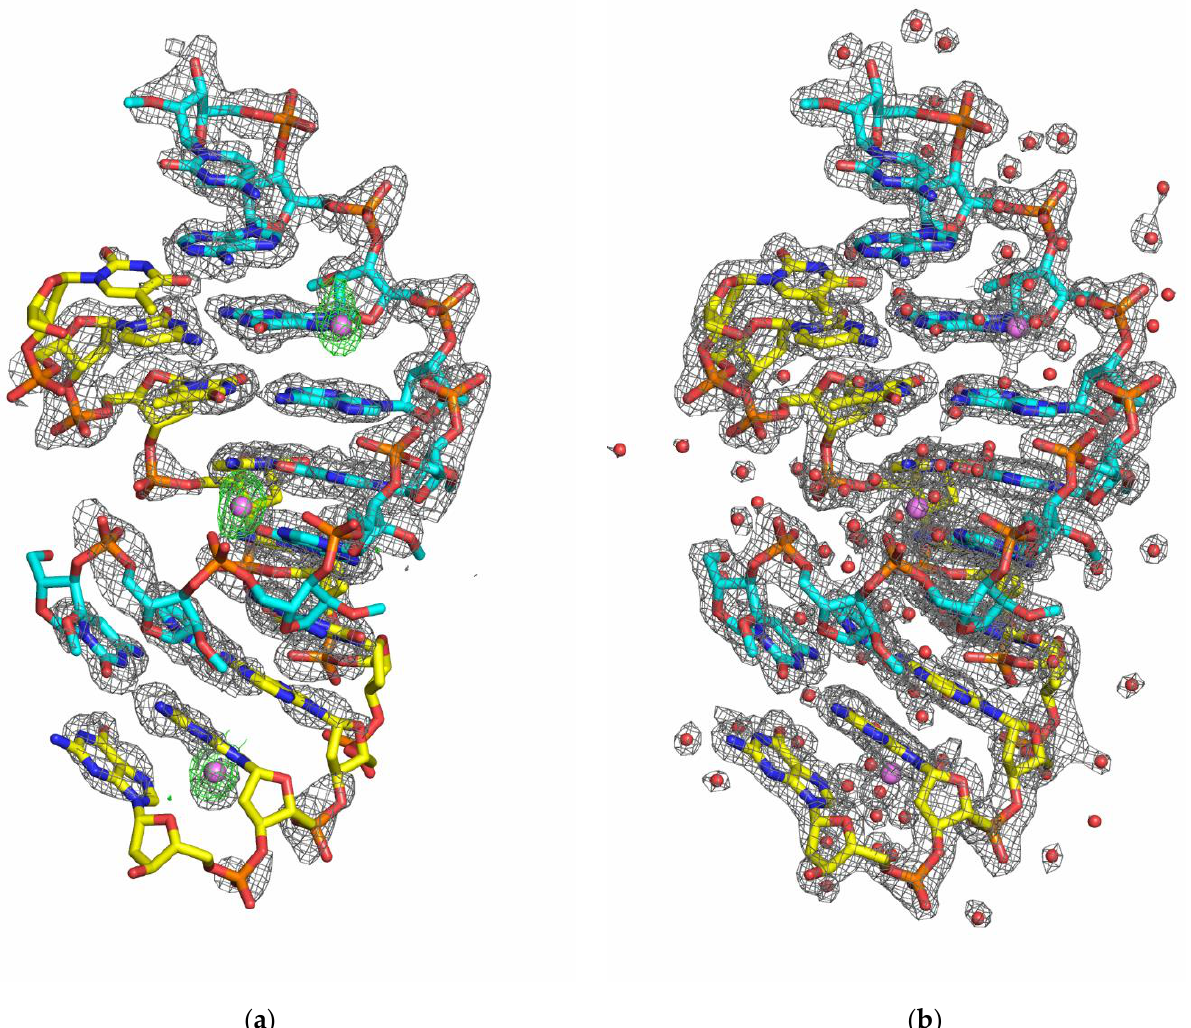
Figure 3. The crystal structure of the overhanging DNA:2 (cid:48) -OMe-RNA duplex. ( a ) The initial density- modified electron density map contoured at the 1.0 σ level (SHELXE output; grey mesh) with an anomalous electron density map contoured at the 3.0 σ level (green mesh) and the refined structure of the overhanging duplex with Zn 2+ . ( b ) The final 2F O -F C electron density map (grey mesh) contoured at 1.0 σ and the refined structure of the overhanging duplex with Zn 2+ . The DNA and 2 (cid:48) -OMe-RNA strands are shown as sticks in yellow and cyan color schemes, respectively. Zn 2+ ions and water molecules are shown as purple and red spheres,